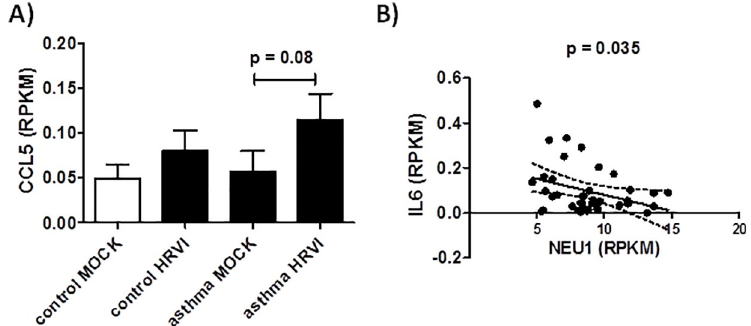
Fig 8. Increase of CCL5 production in children without asthma. Specific increase (A) and linear correlation of IL6 and NEU1 mRNA expression in nasal epithelial cells from children without asthma (r 2 = 0.11) (B).